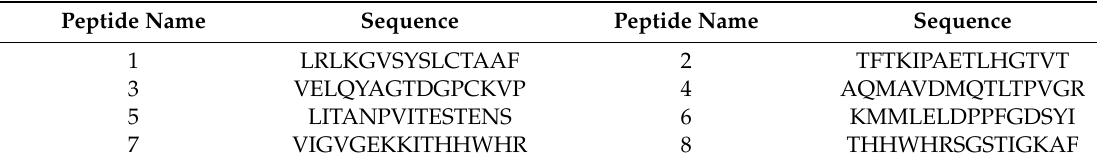
Table 1. Zika virus (ZIKV) DIII of E (EDIII) protein peptides used for stimulation of cellular immune